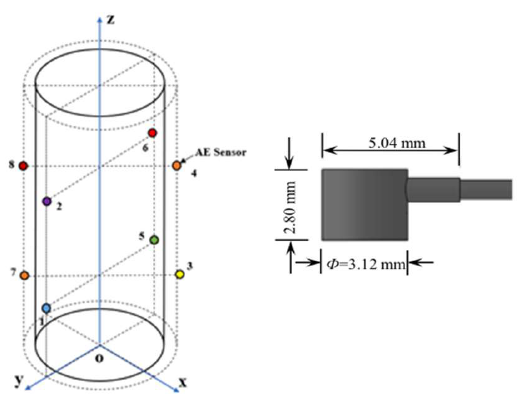
Figure 3. Distributions and dimensions of an AE sensor.